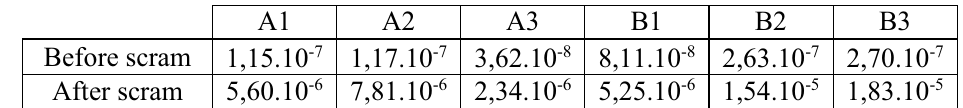
Table III. ((cid:15), 9) reaction rates (in s-1 with source neutron normalized to 1 n/s) on boron